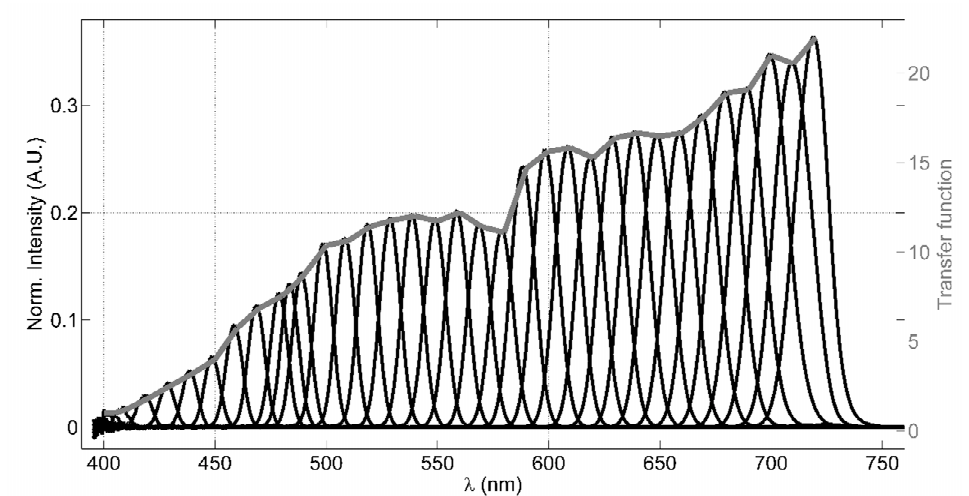
Figure 2. The LCTF transfer test results: (1) the black lines represent the intensities measured at each tuned wavelength by the spectrometer normalized by the light source spectrum; (2) the grey line is the evaluated transfer function.